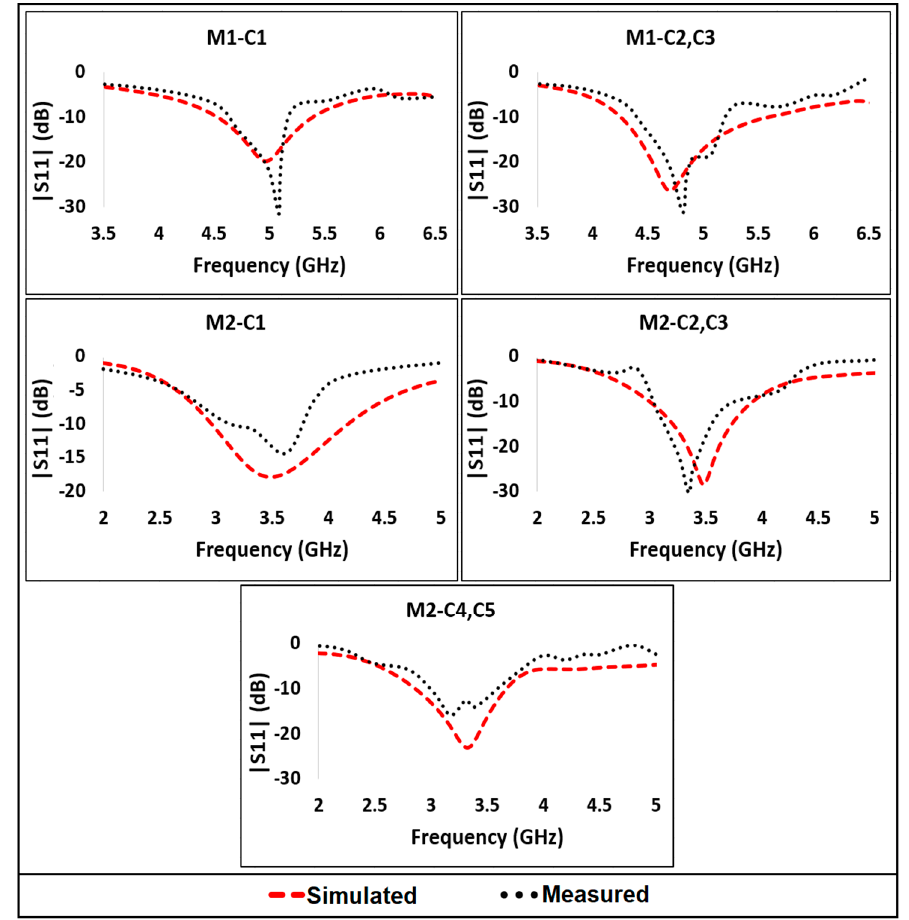
Figure 7. Measured and simulated |S11| for Cases of Modes 1 and Mode 2.